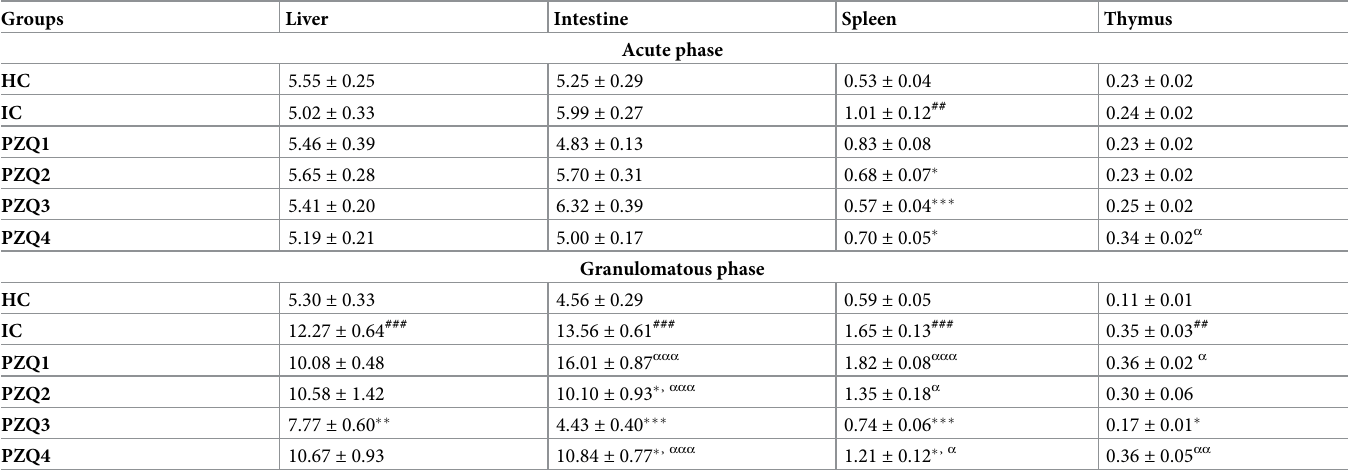
Table 2. Effect of praziquantel treatment on the relative organ weight (g/100g body weight) of Schistosoma mansoni -infected mice. Groups Liver Spleen Thymus